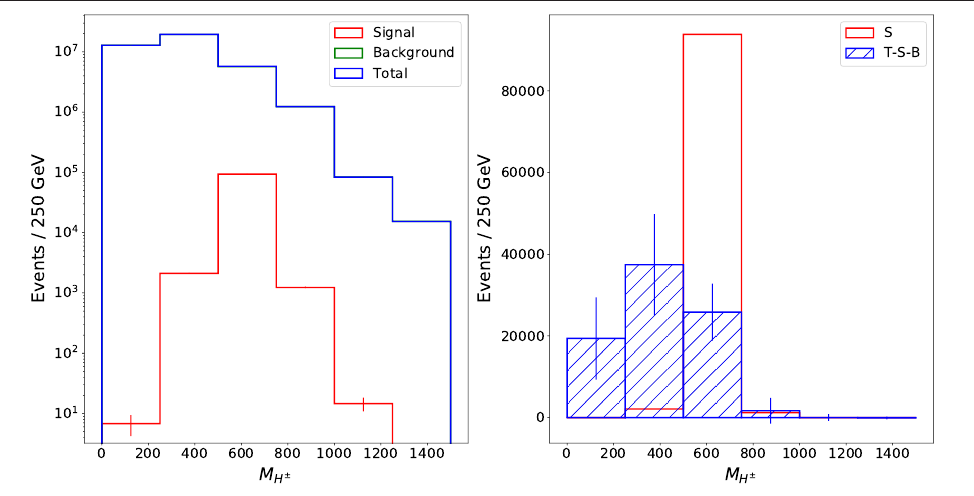
Figure 4. The charged Higgs invariant mass distribution of the signal, background and total samples (left) and interference and signal (right) at parton level and without cuts in the h MSSM scenario.